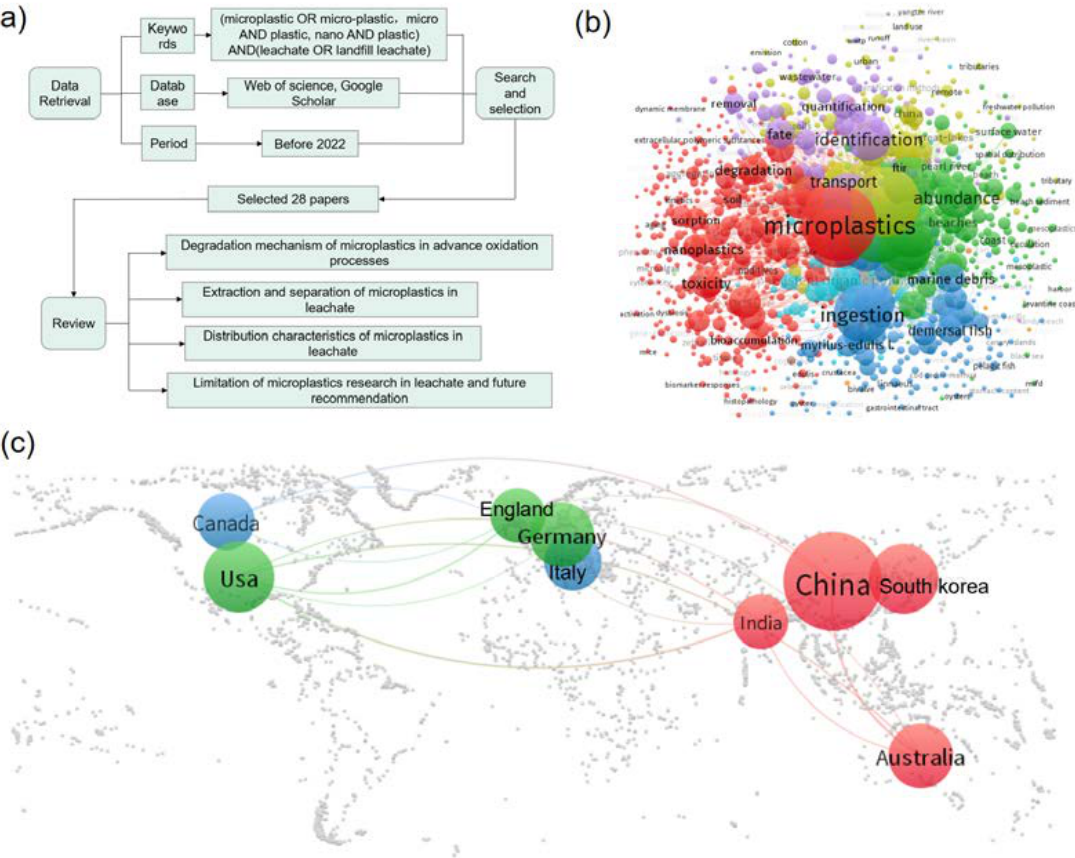
Figure 1. ( a ) The framework of this work; ( b ) key points on microplastics in the existing literature; ( c ) countries covered in the existing literature on microplastics in leachate.